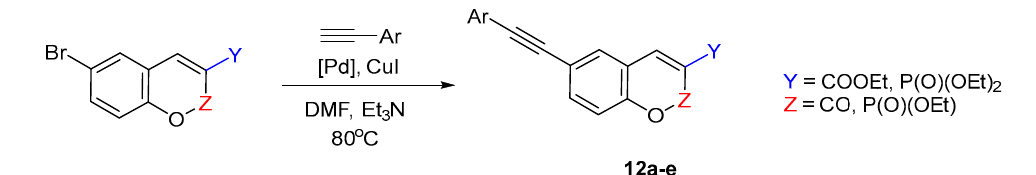
Table 6. Parameters, reagents, and products of palladium-catalyzed alkynylation of 3-substituted coumarin species—Sonogashira